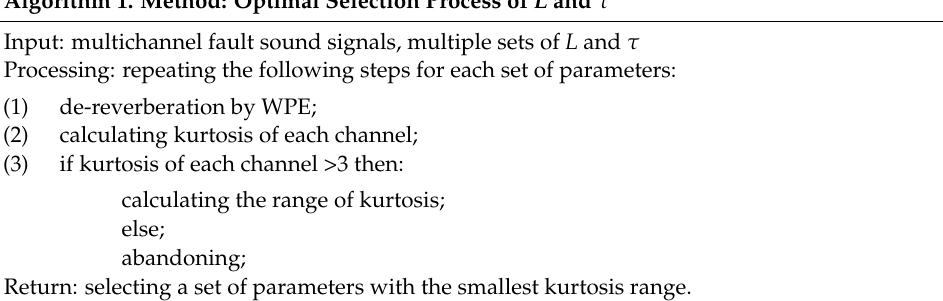
Algorithm 1. Method: Optimal Selection Process of L and